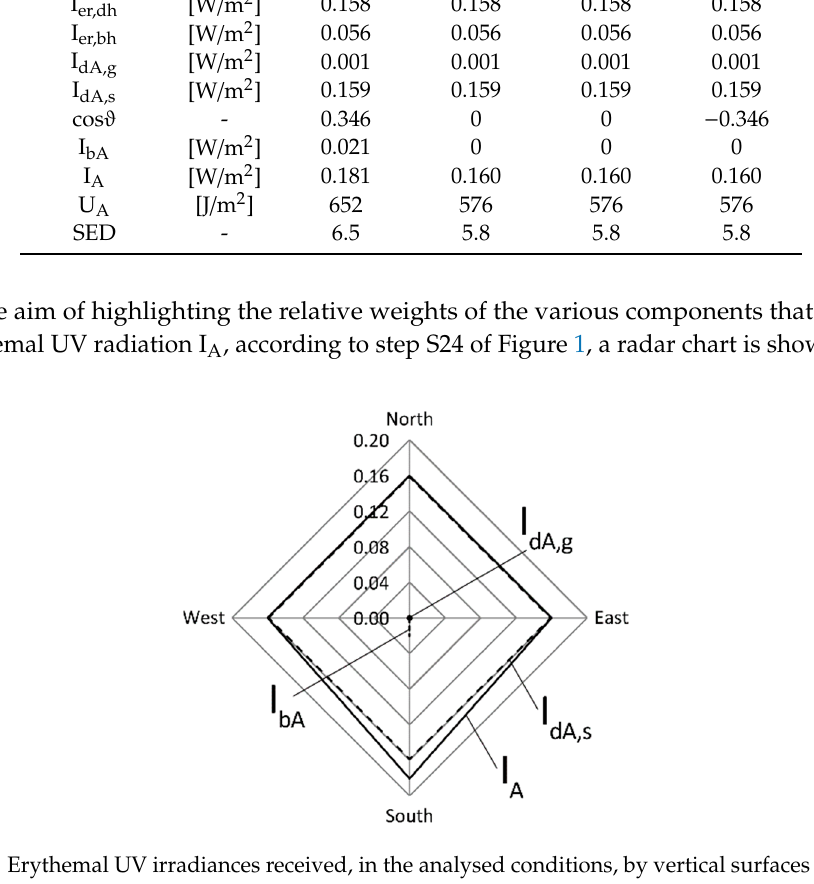
Table 3. Calculation results for vertical surfaces facing the four cardinal points (21 June, solar noontime).